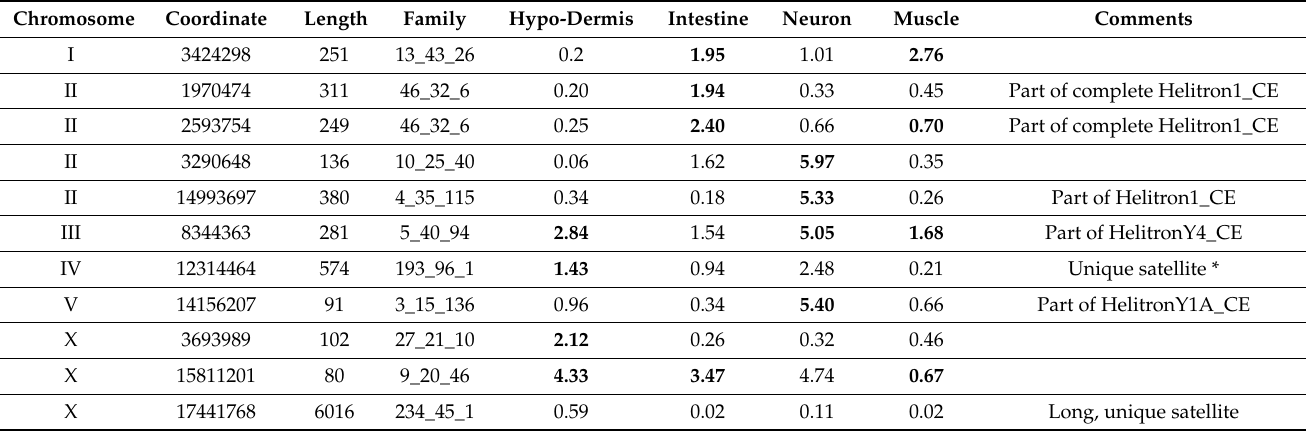
Table 1. Satellites with the highest transcription in each tissue (RPKM